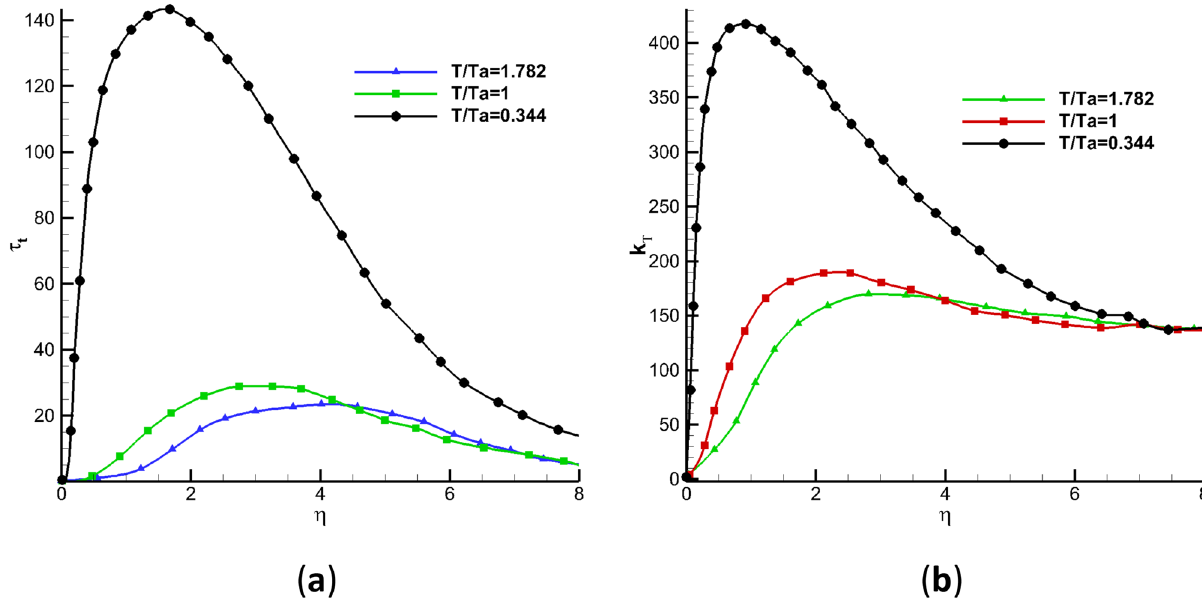
Figure 17. Distribution laws of Reynolds shear stress and turbulent kinetic energy of boundary layer: (a) Reynolds shear stress; (b) turbulent kinetic